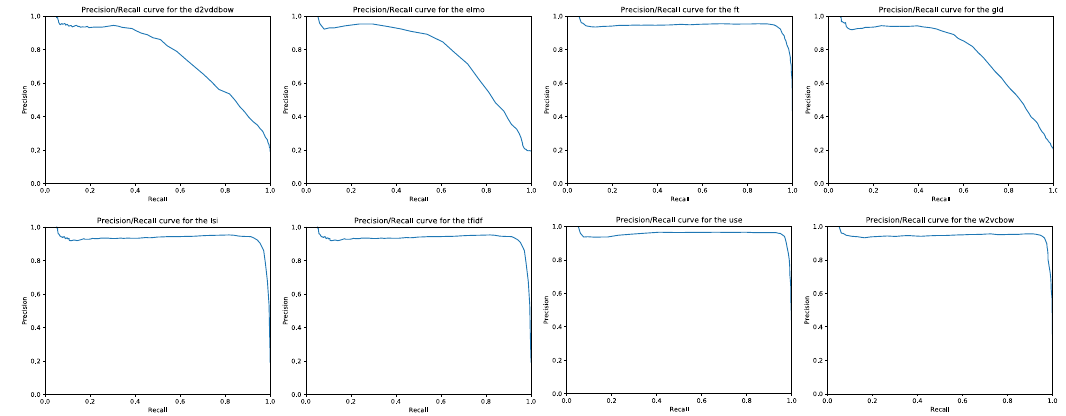
Figure A1. Precision/recall curves for eight models processing C&S corpus. Information 2020 , 11 , x FOR PEER REVIEW